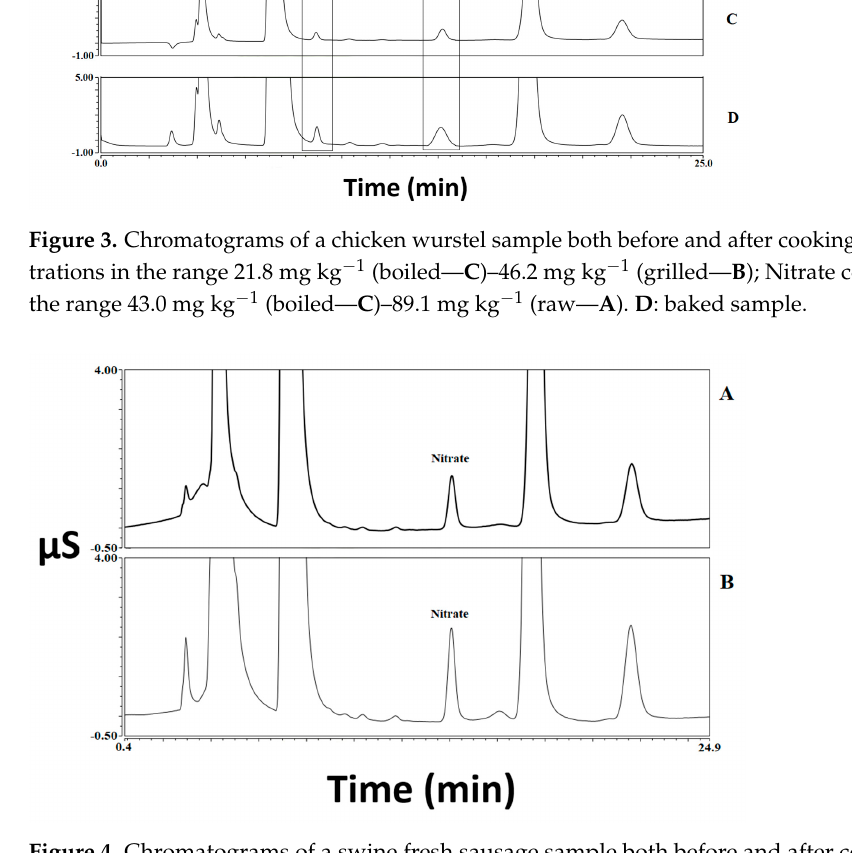
Figure 4. Chromatograms of a swine fresh sausage sample both before and after cooking (extracts diluted 1/5). Nitrate concentrations: 134.6 mg kg − 1 (raw— A ); 233.6 mg kg − 1 (grilled— B